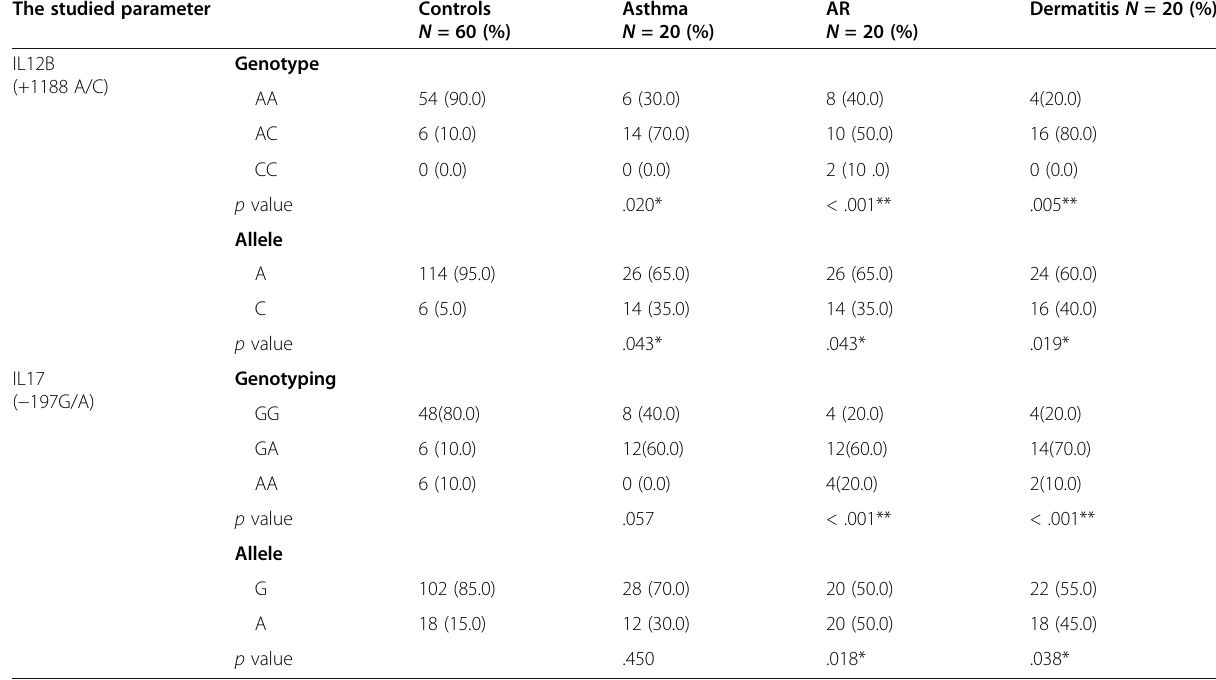
Table 7 Genotype and allele frequencies of IL12B (+1188 A/C) and IL17A ( − 197G/A) polymorphisms among studied groups The studied parameter